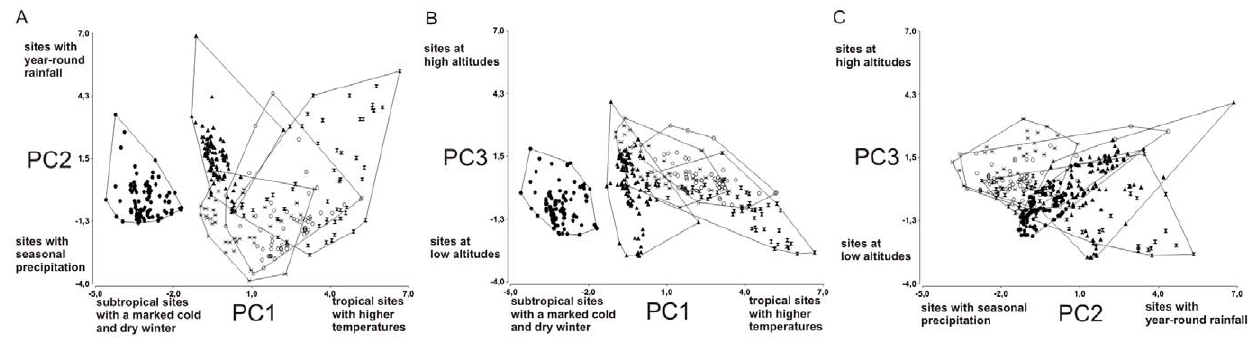
Figure 7. Principal components analysis (PCA) of continental species of the genus Epicrates for the first two PC axes (A), the first and the third (B) and the second and the third (C). The PC1 explains 51%, the PC2 explains 22% and the PC3 explains 11% of the variation. Total variation explained by the first three principal components is 84%. E. alvarezi (black circles), E. crassus (black triangles), E. assisi (stars), E. cenchria (black sandglass) and E. maurus (white circles).